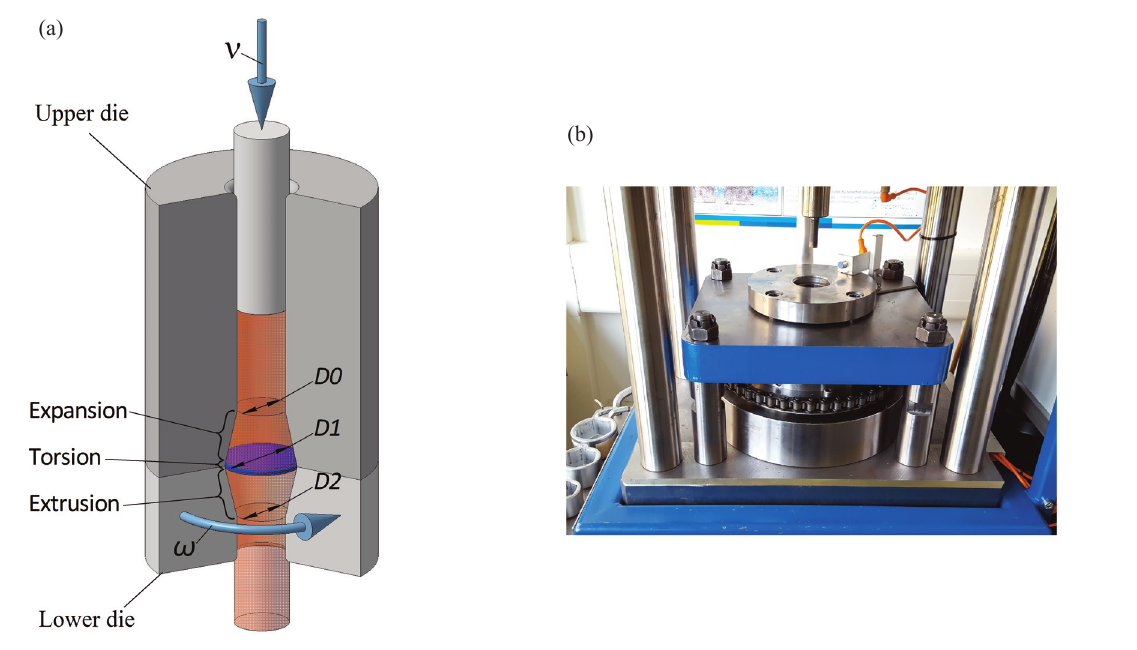
Fig. 1. HPTE die. (a) 3D illustration of the die and the channels; (b) the assembled